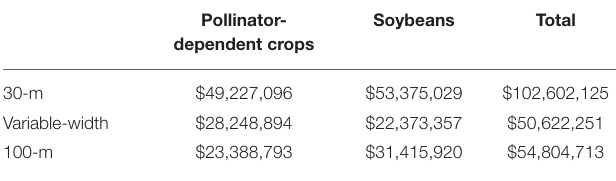
TABLE 9 | Summary of estimated pollination value for each buffer scenario. TABLE 11 | Summary of final benefits and costs in 2016U.S. dollars per